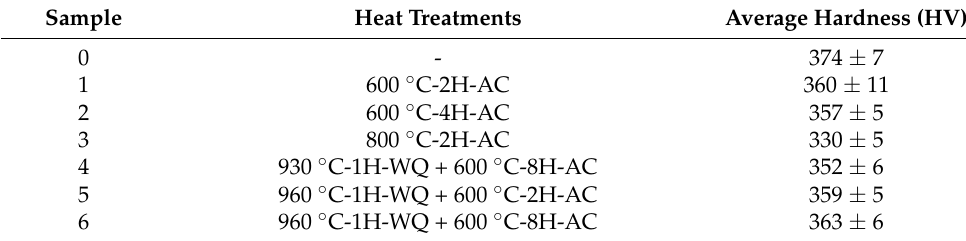
Table 3. Hardness of SLM TC4 under different heat treatments.